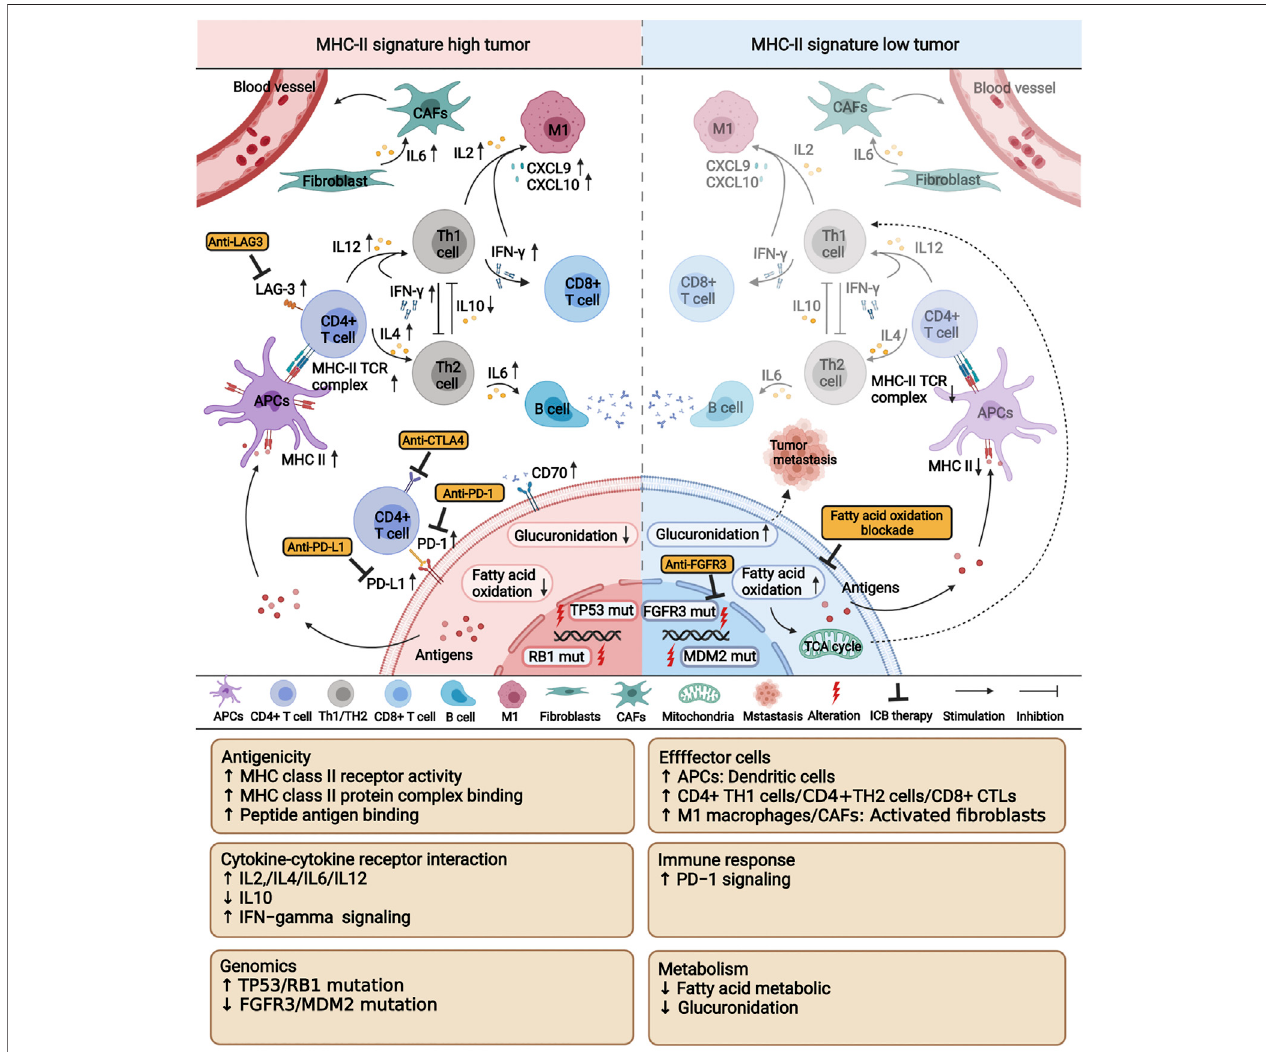
FIGURE 8 | A proposed mechanism underlying the improved ef fi cacy and prognosis in bladder cancer patients with high MHC-II signature after immunotherapy. This picture was created with BioRender.com (https://app.biorender.com/biorender-templates).